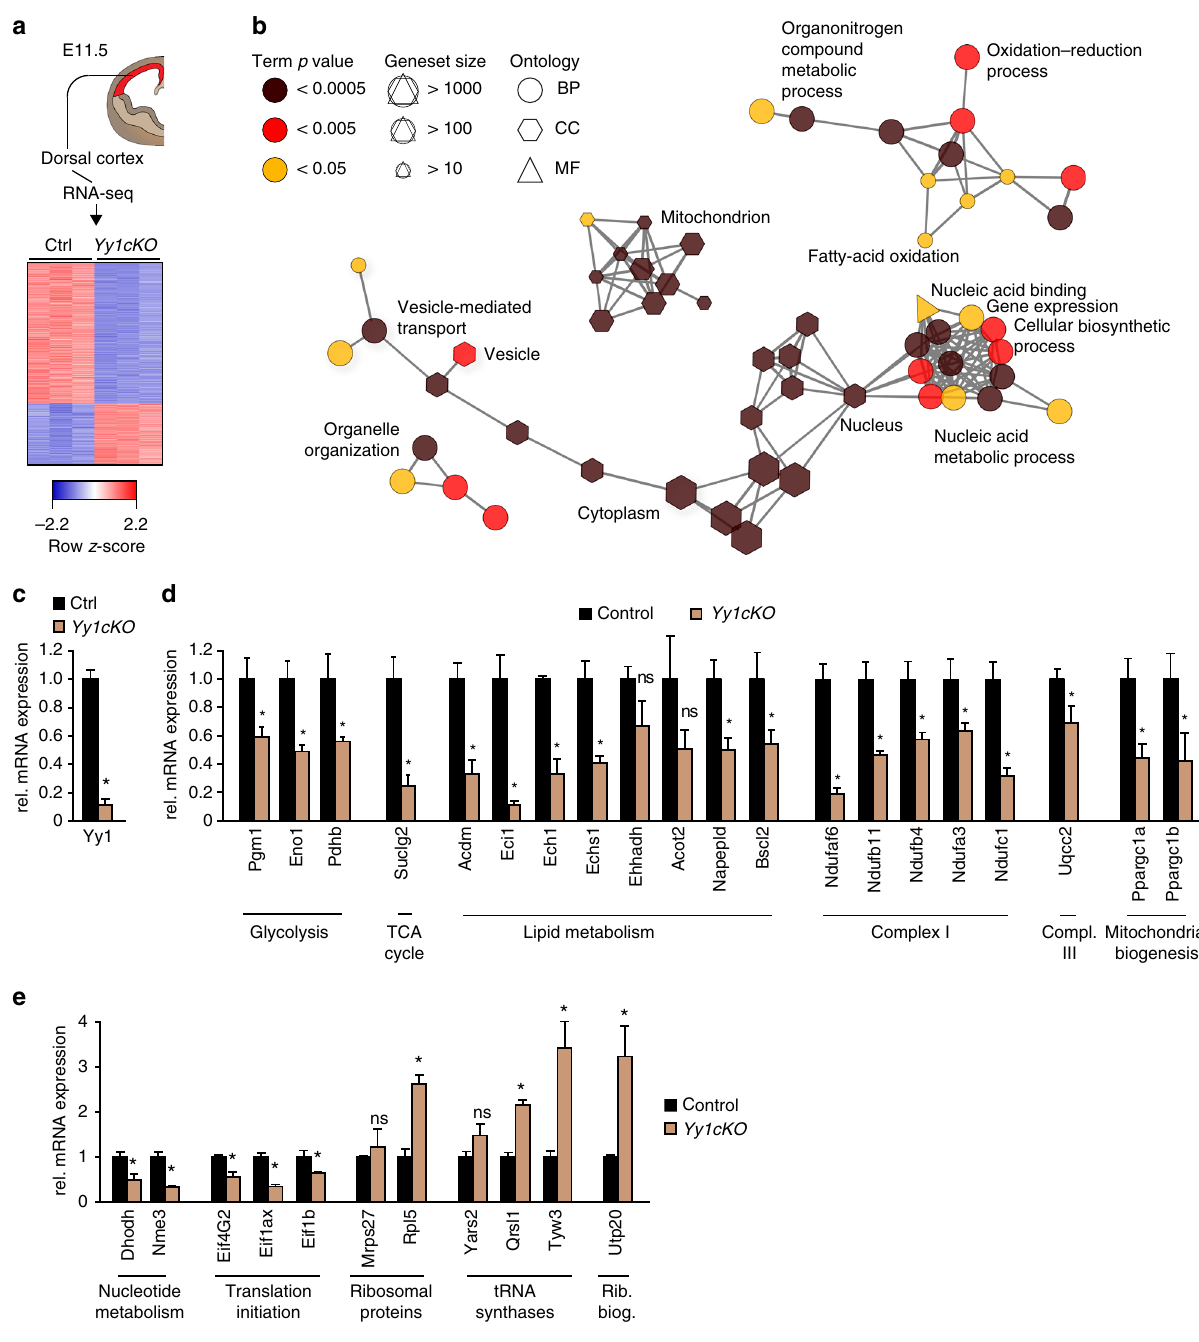
Fig. 4 Yy1 regulates the expression of metabolic genes. a RNA-seq comparing Yy1cKO versus control cortex tissue at E11.5 identi fi ed 1554 differentially expressed genes (|log2 fold change| > 0.3, p < 0.05, FDR < 0.01). b Gene Ontology (GO) term network analysis on the basis of differentially regulated genes. Each node represents an enriched GO term (adjusted p value (Corrected with Bonferroni step down procedure) < 0.05). Nodes are interconnected when the gene overlap is > 50%, based on the kappa score. BP, biological process; MF, molecular function; CC, cellular component. A fully labeled version of the network is given in Supplementary Fig. 6. c – e qRT-PCR validation for differentially regulated genes comparing control vs Yy1cKO cortical tissue at E12.5 con fi rms RNA-seq results. Comparisons were performed using the two-tailed unpaired Student ’ s t test. Data are the mean ± standard